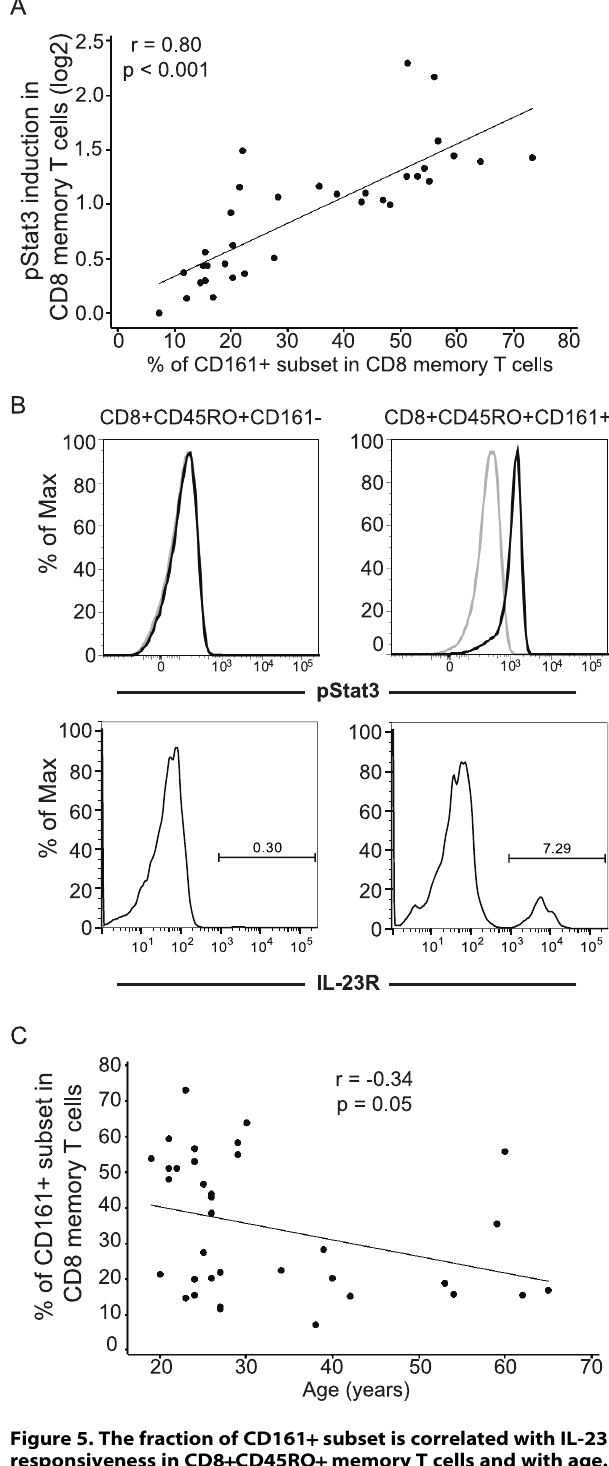
Figure 5. The fraction of CD161 + subset is correlated with IL-23 responsiveness in CD8 + CD45RO + memory T cells and with age. (A) The fraction of the CD161 + subset in CD8 + CD45RO + memory T cells is positively correlated (n=35, r=0.80; p , 0.001) with IL-23 responsive- ness, measured by whole blood phospho-flow for IL-23-mediated pSTAT3 induction (log2). (B) Upper panel: FACS-sorted CD3 + CD8 + CD45RO + CD161 + or CD161 2 T cells were stimulated with or without 100 ng/ml IL-23 for 15 minutes and pSTAT3 induction was assessed by phospho-flow. Representative flow cytometry plots are shown from one of the three individuals assessed. IL-23 responsive CD8 + CD45RO + T cells are confined to the CD161 + fraction.